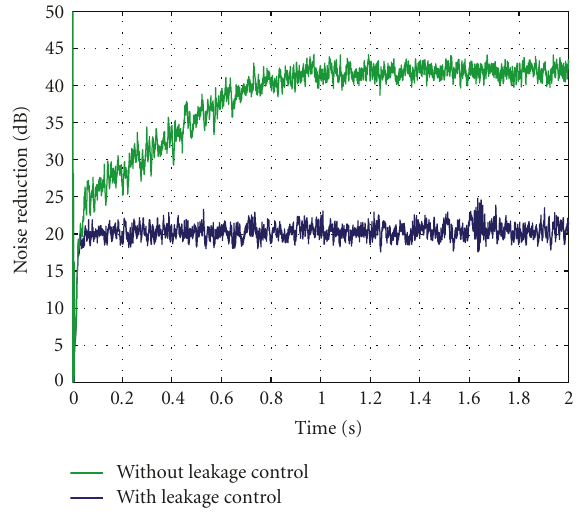
Figure 8: E ff ect of leakage control in a simulated anechoic environ- ment. The maximum noise reduction is limited to approximately 20 dB.